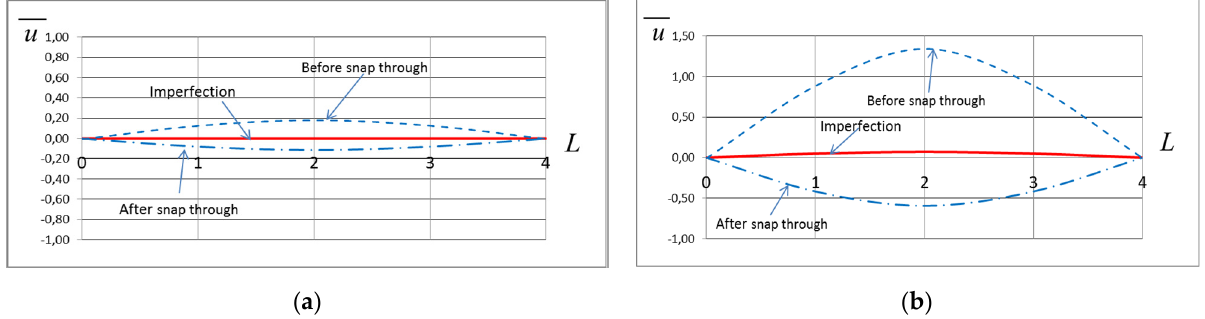
Figure 7. Configuration of displacement before and after snap-through for initial amplitudes of geometrical imperfections developed according to the first buckling mode: ( a ) small ( m 1), ( b ) large ( d 1).